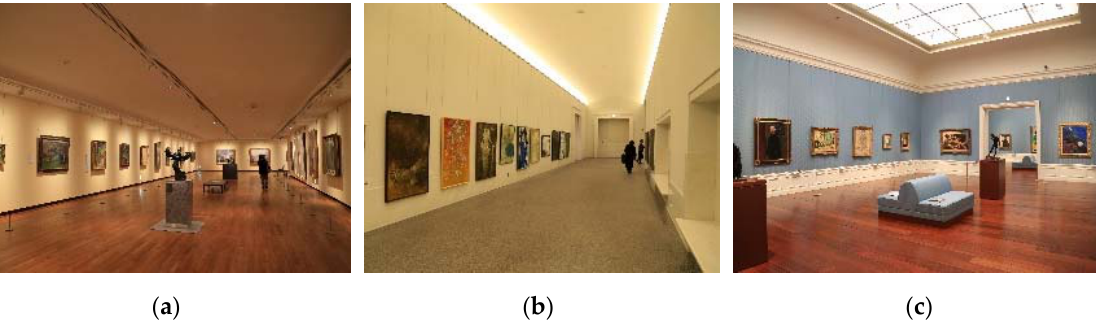
Figure 2. Three museum lighting environments. ( a ) The national museum of western art. ( b ) The Aichi Prefectural museum of art. ( c ) The Yamazaki Mazak museum of art.